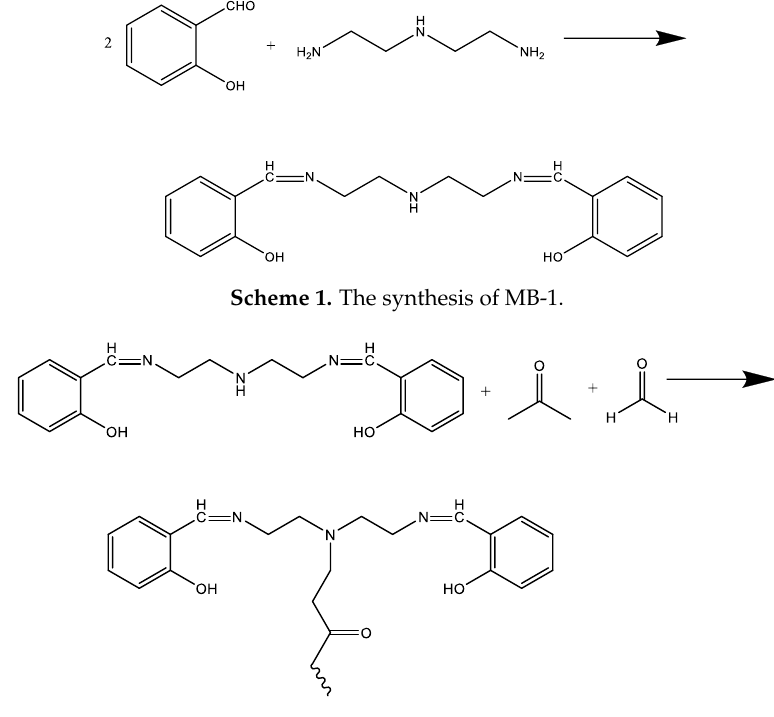
Scheme 2. The synthesis of